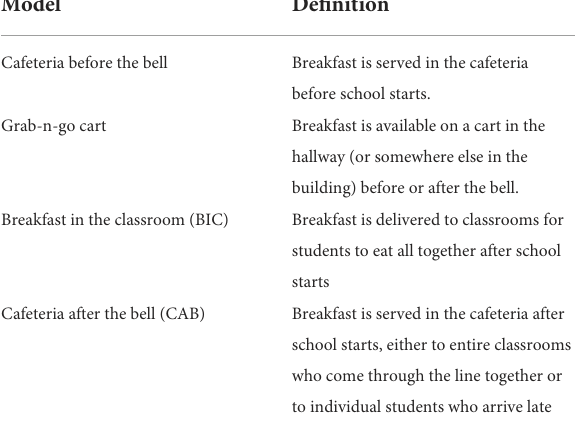
TABLE 1 Breakfast service models and